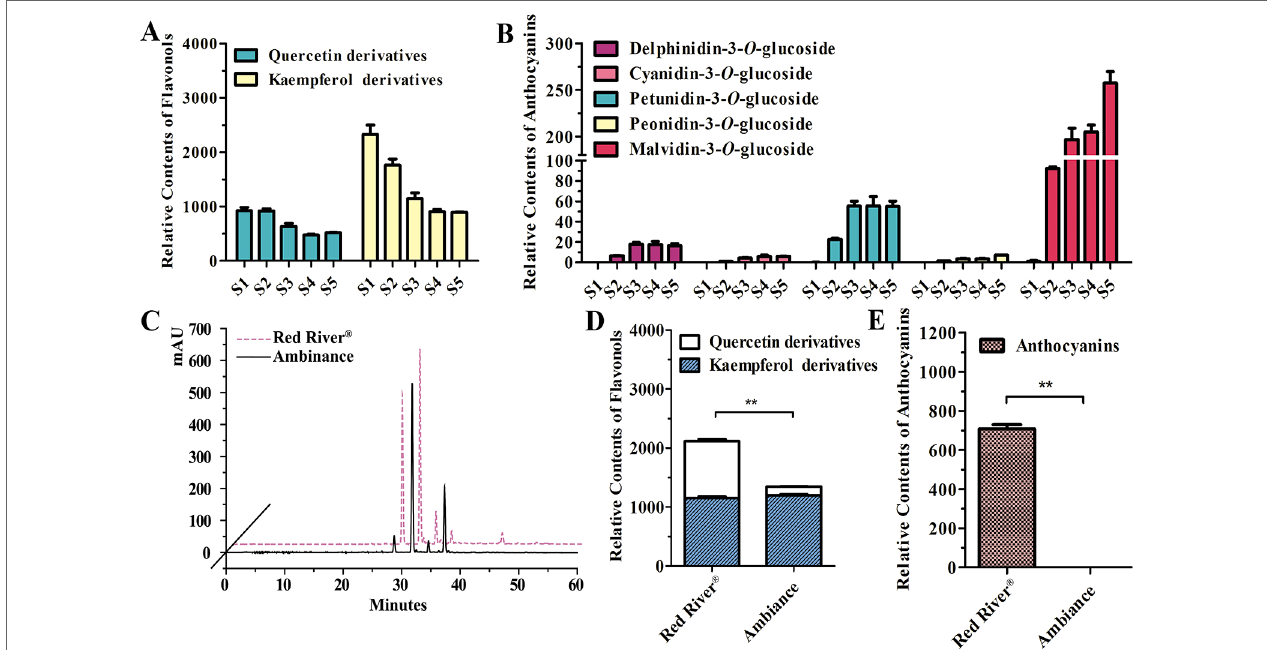
FIGURE 1 | Quantitative analysis of anthocyanins and flavonols. (A and B) Relative contents of flavonols and anthocyanins during flower development of Red River ® . (C) Peak patterns of flower flavonols analyzed by HPLC. (D and E) Relative contents of flavonols and anthocyanins in flowers of Red River ® and Ambiance. Relative content was represented by the peak area of HPLC analysis. S1 – S5 represented the different developmental stages of flowers. Data represented the means ± SD of three biological replicates. T test was carried out to analyze the significant difference (** P <